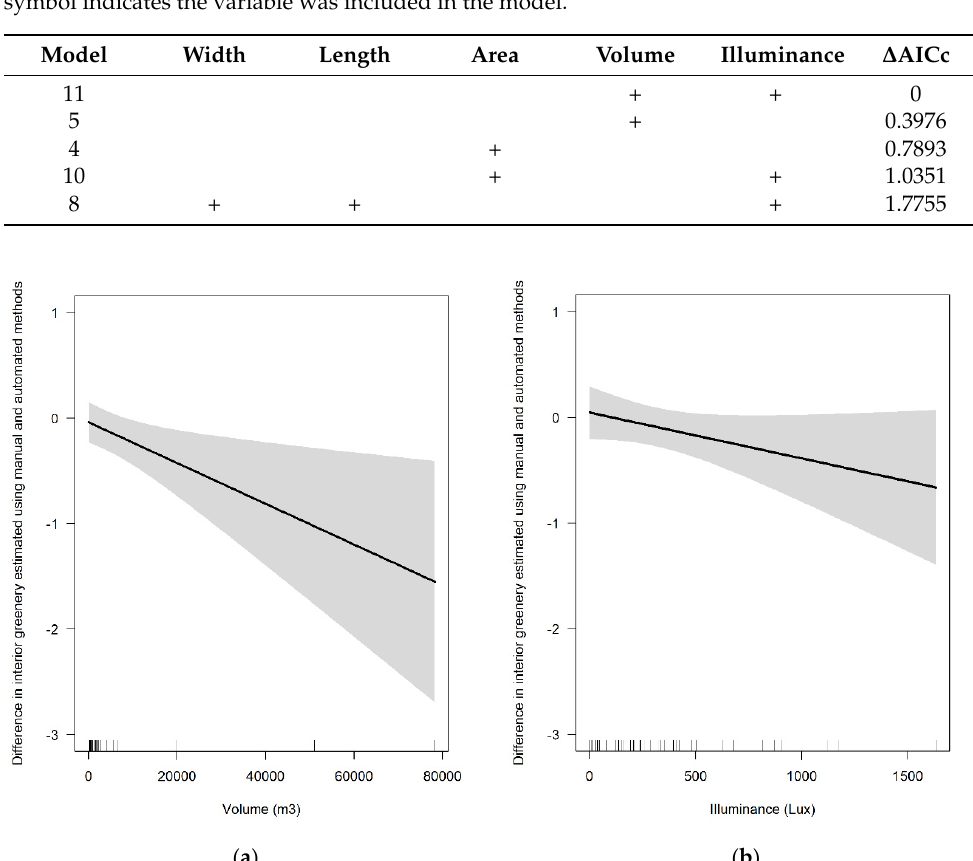
Figure 6. Predicted differences (mean ±95% confidence interval) for greenery within interior spaces estimated from 360° panoramic images using the manual and automated methods with changes in ( a ) interior volume (m 3 ) and ( b ) illuminance (lux). Predictions were made using Model 11 in Table 3, which is the linear regression model with the strongest empirical support (i.e., lowest ∆ AICc